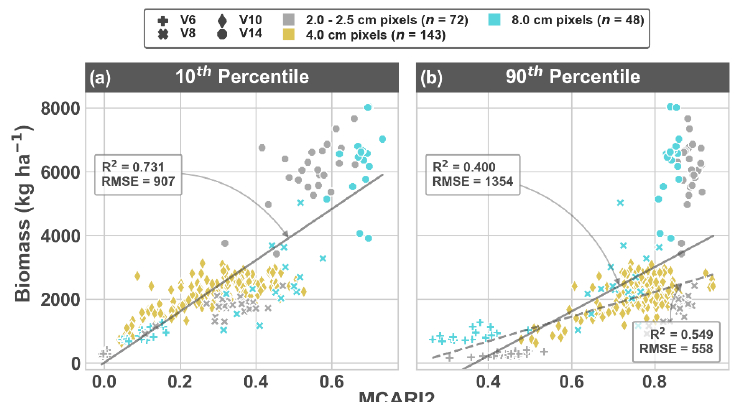
Figure 4. Relationship between above-ground biomass and MCARI2 (Modified Chlorophyll Absorption Ratio Index Improved) 10th ( a ) and 90th ( b ) percentile values. Best fit lines from ordinary least squares linear regression are illustrated, as well as their respective coe ffi cient of determination (R 2 ) and root mean squared error (RMSE). The dashed line in (b) represents the best fit from ordinary least squares